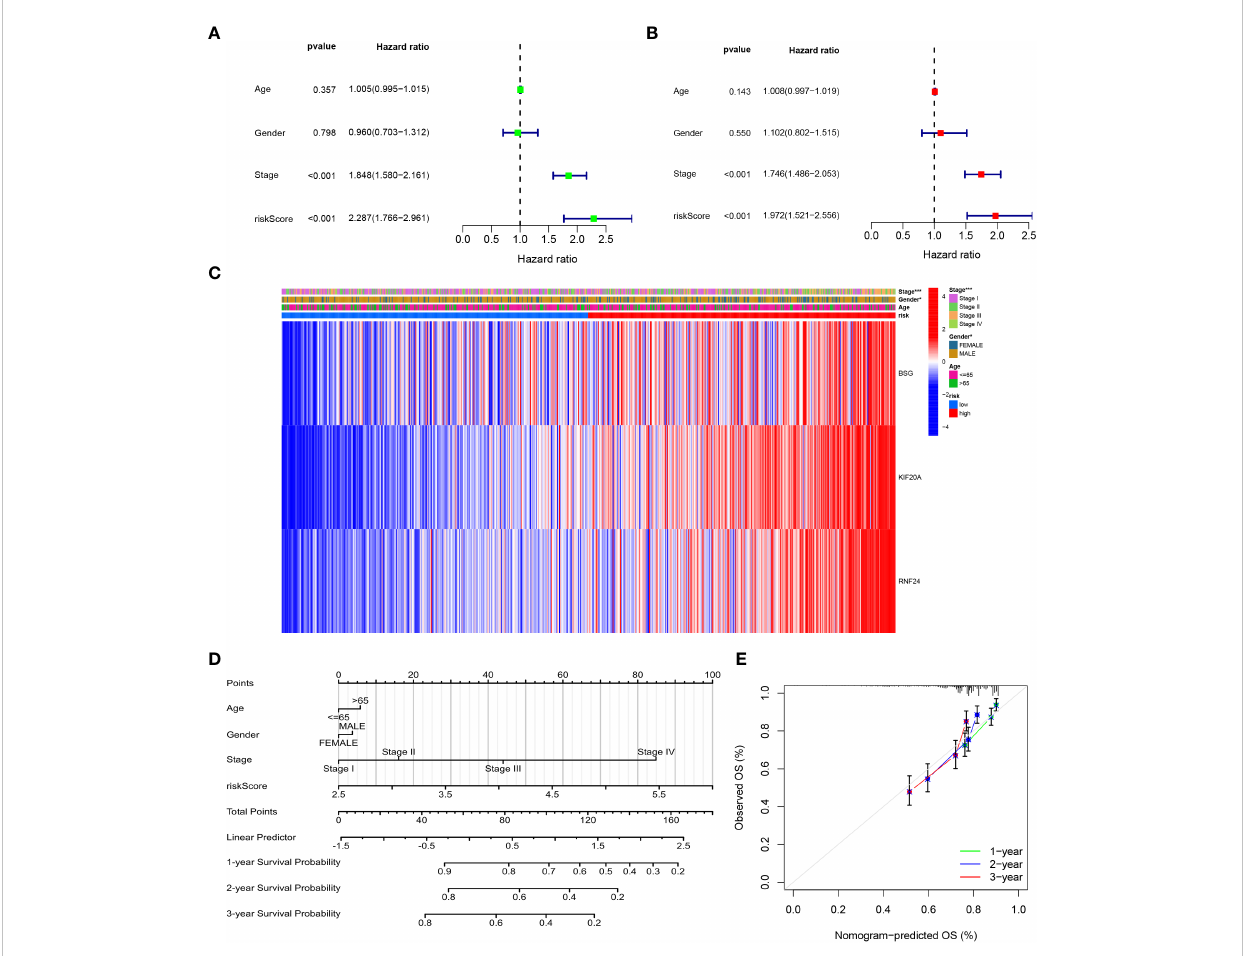
FIGURE 10 Independent prognostic analysis and Construction and validation of the Nomograms. (A) Univariate cox regression analysis for the TCGA cohort. (B) Multivariate cox regression analysis for the TCGA cohort. (C) The correlations between the GARGs and clinicopathologic characters of the high- risk group and low-risk group were shown as a heatmap. (D) Construction of the Nomograms. (E) The calibration curves displayed the accuracy of the nomogram in the 1-, 2- and 3